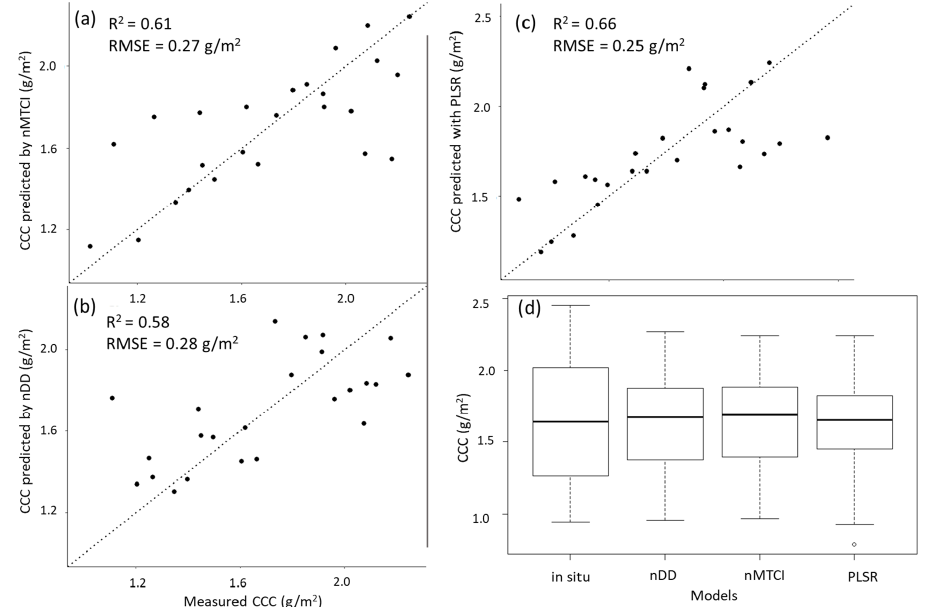
Figure 5. Scatterplot of the in situ CCC and predicted values made by ( a ) nMTCI with optimal wavelength combinations, ( b ) nDD with optimal wavelength combinations, and ( c ) Partial least squares regression (PLSR) with five components. The dotted line shows the 1:1 relationship between predicted and measured values. ( d ) Boxplot of in situ and predicted CCC (g/m 2 ) using the three selected models. Mean CCC was 1.64 g/m 2 for all models as well as in situ CCC. The median predicted CCC was 1.67 g/m 2 , 1.69 g/m 2 and 1.65 g/m 2 for nDD, nMTCI and PLSR, respectively. The median in situ CCC was 1.64 g/m 2 .